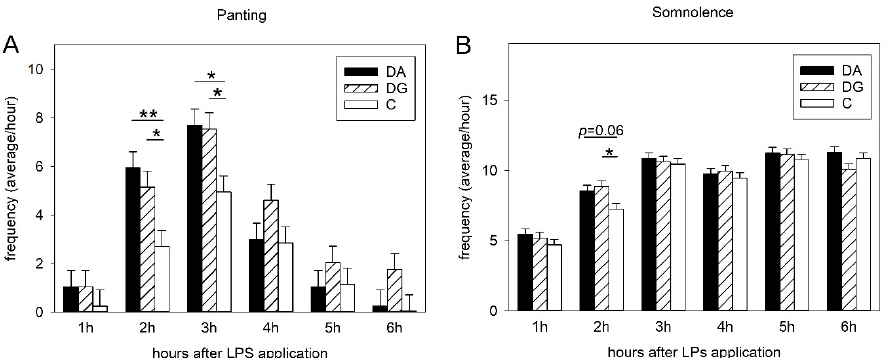
Figure 1. Sickness symptoms of panting ( A ) and somnolence ( B ) after LPS challenge in the three treatment groups of DA (deprivation alone), DG (deprivation with a group of littermates) and C (control, no deprivation). Significant differences are indicated by asterisks (* p < 0.05; ** p < 0.01; n = 20 pigs per treatment group).